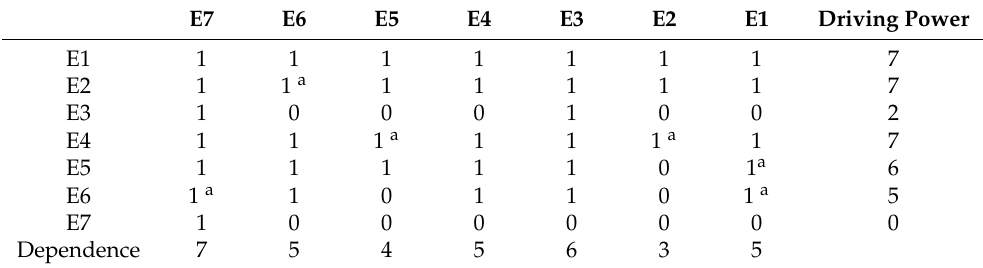
Table 6. The reachability matrix of GTA.